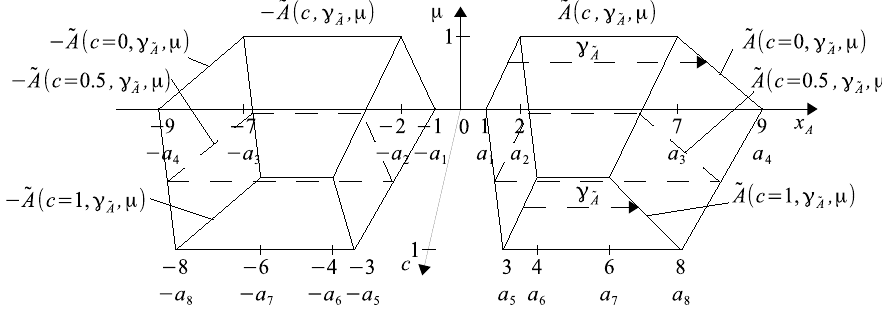
Figure 20. Type 2 fuzzy number ˜ A and its negative version − ˜ A (opposite number).